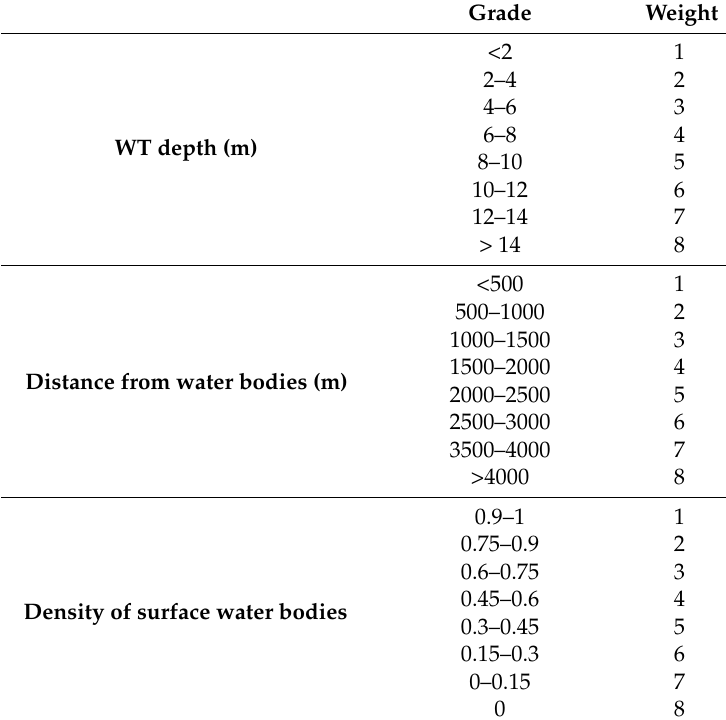
Table 4. The value system for ecological resistance